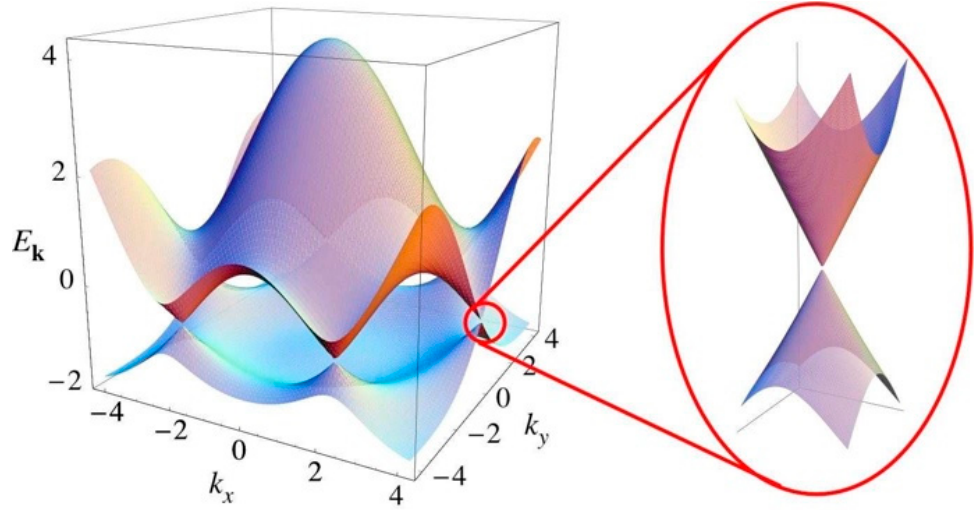
Figure 1. Energy spectrum of monolayer graphene. Right: a zoomed in view of the energy bands close to the Dirac point.